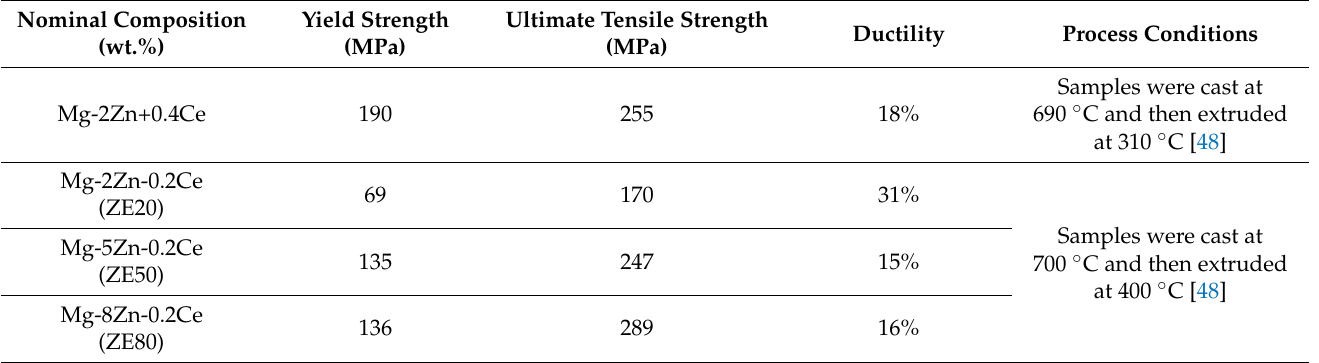
Table 4. Mechanical properties of Mg-Zn-Ce